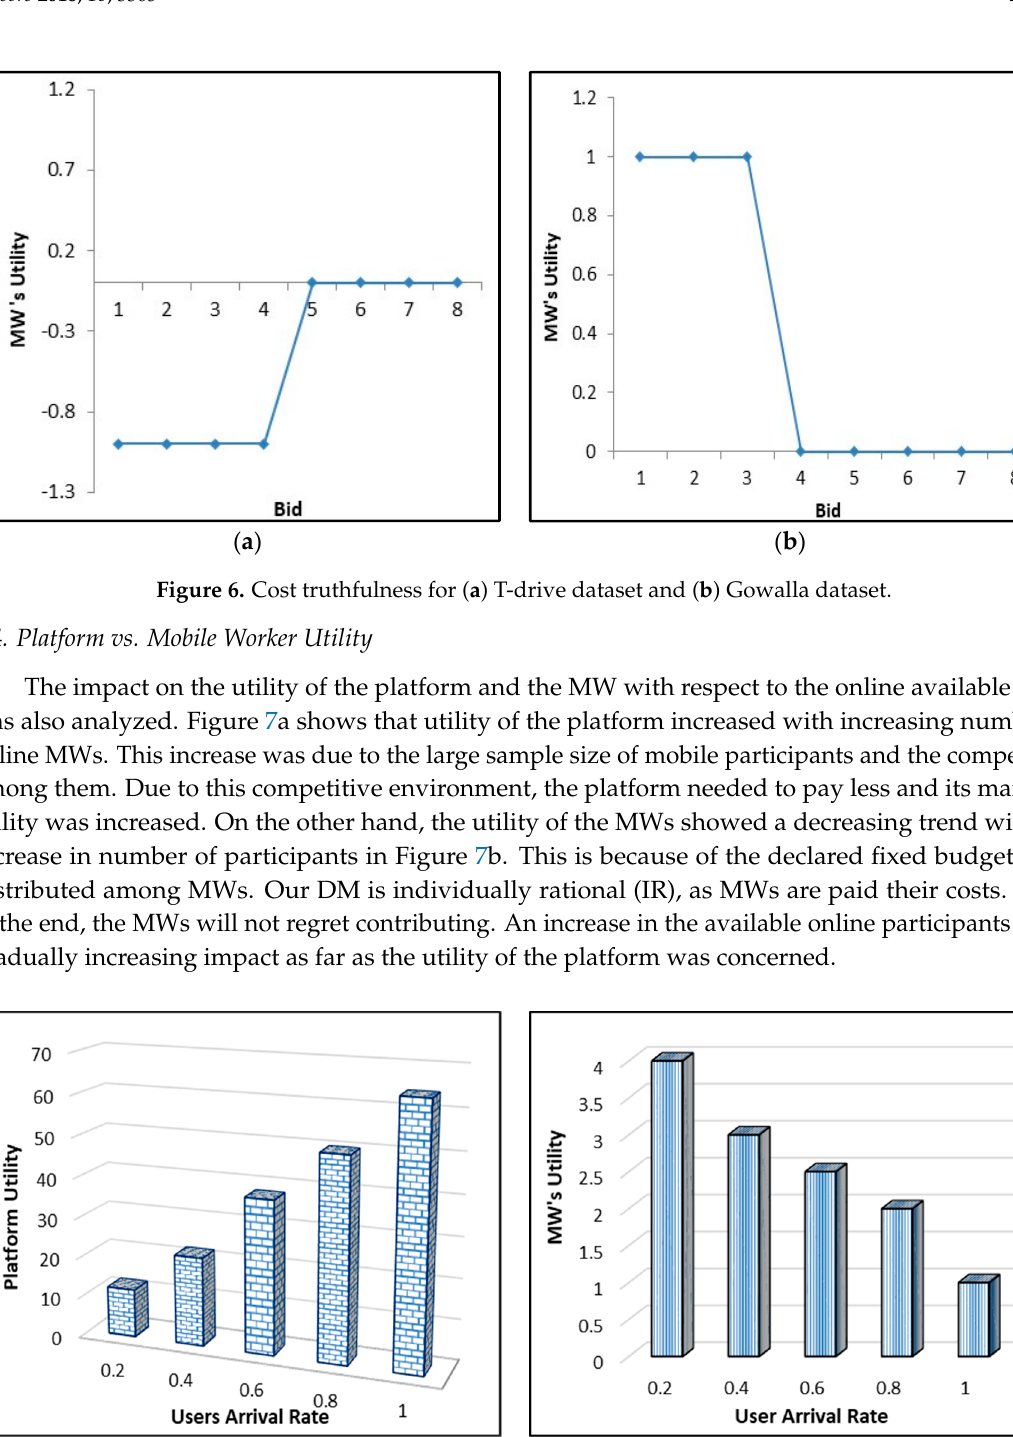
Figure 5. Effect of change in the number of MWs on the platform utility.